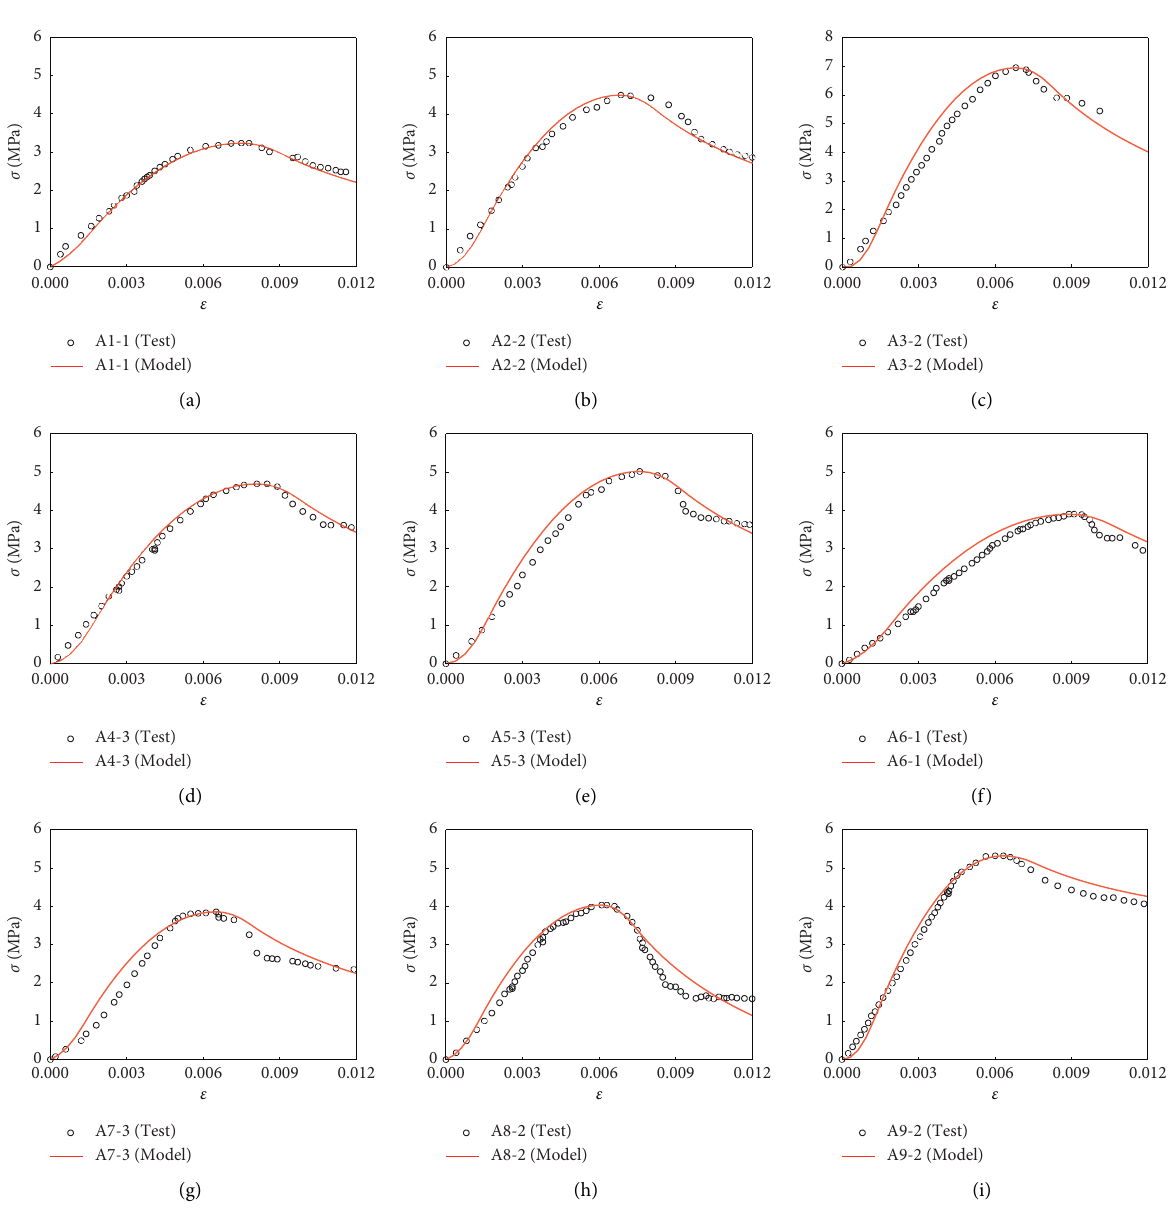
Figure 24: Comparison between the predicted and measured stress-strain